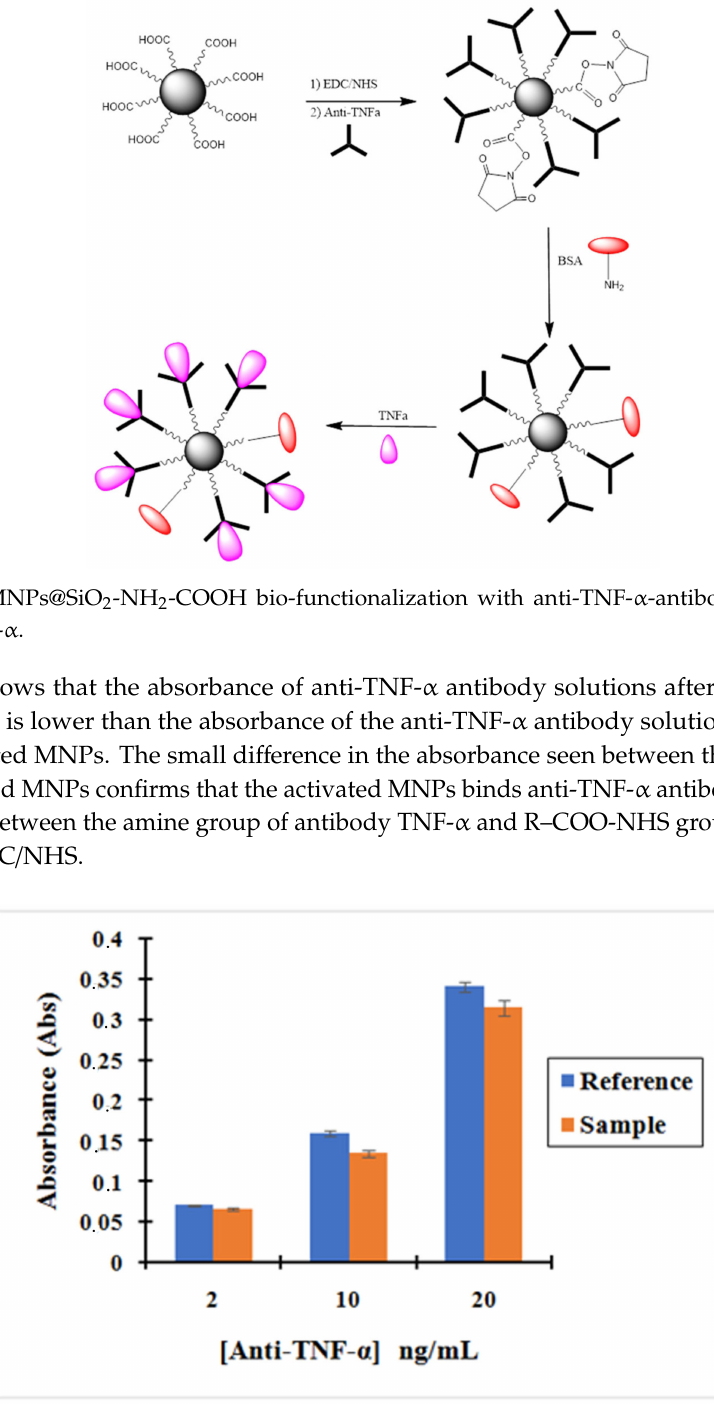
Figure 6. Bar graph showing (blue) the measurement of the absorbance solutions obtained after the immobilization of anti-TNF- α with activated MNPs (with 1-ethyl-3-(dimethylaminopropyl) carbod (EDC) / N-hydroxysuccinimide (NHS)) at di ff erent concentrations: 2, 10, and 20 ng / mL; (Orange) the measurement of the absorbance solutions obtained after the immobilization of anti-TNF- α with non-activated MNPs (without EDC / NHS) at di ff erent concentration: 2, 10 and 20 ng / mL. Error bars correspond to three replicates per